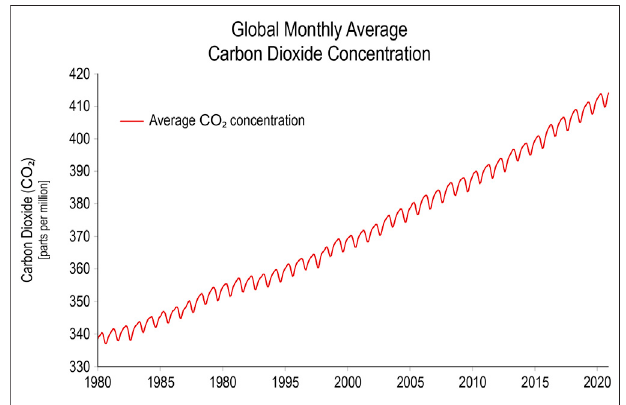
FIGURE 3 | Changes in carbon dioxide concentration between 1970 and 2020 (Lindsey,